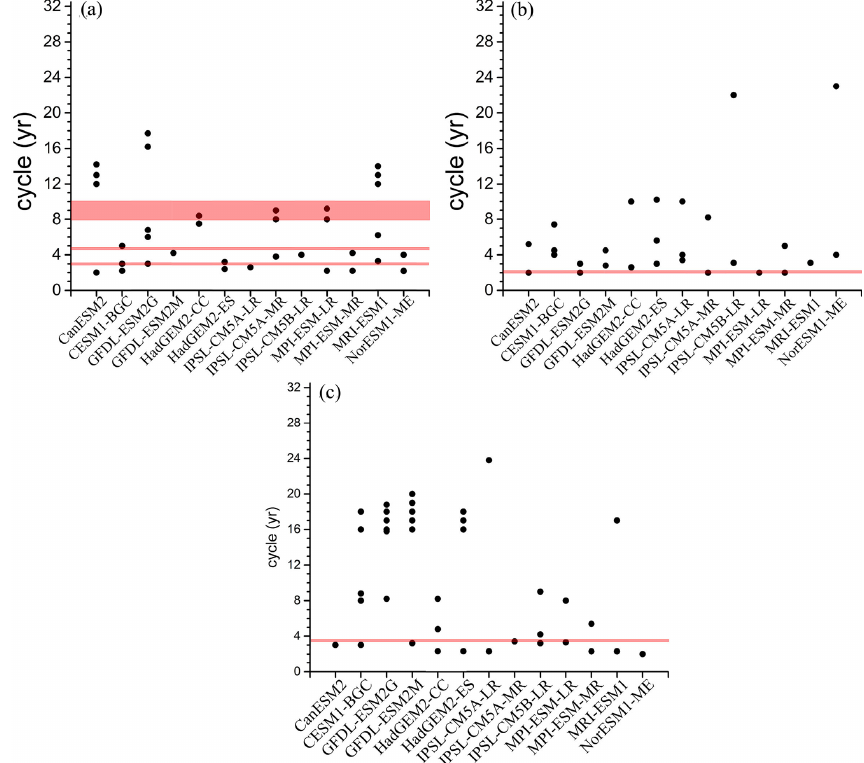
Figure 3. Periodicities of the observed and simulated winter-average NAO indices (a) and area-average SST anomalies in the subtropical ( b , 25–45 ◦ N) and subpolar NA ( c , 45–65 ◦ N), determined by power spectrum analysis. The periodicities are determined by calculating the red noise confidence interval and choosing those at the 90% confidence level. The y coordinate of the horizontal lines or areas is the significant period of observation. The time periods for the observation and models range from 1965 to 2015 and from 1955 to 2005, respectively. The simulated results are based on a historical experiment of CMIP5